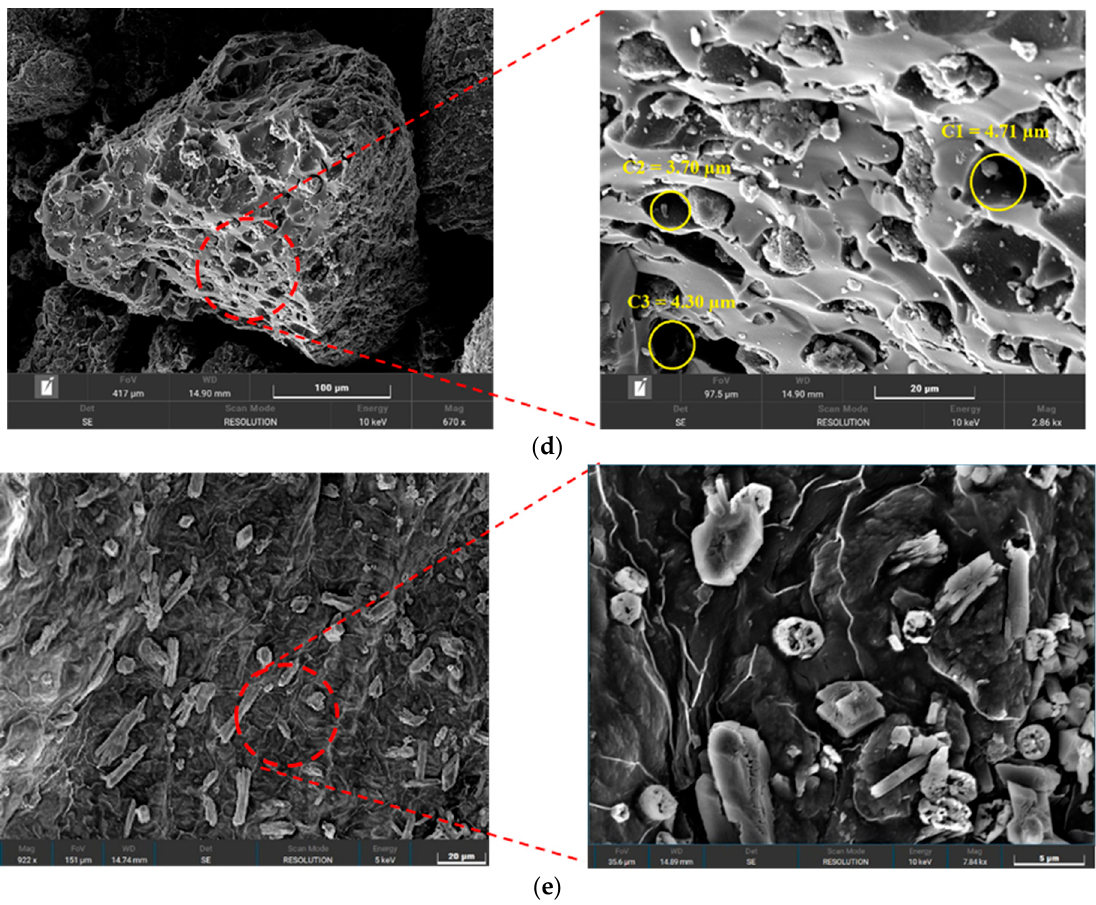
Figure 6. SEM analysis for ( a ) carbon at 400 °C, ( b ) activated carbon at 400 °C, ( c ) carbon at 1000 °C, ( d ) activated carbon at 1000 °C, and ( e ) AC 1000°C MB-0.3:1.